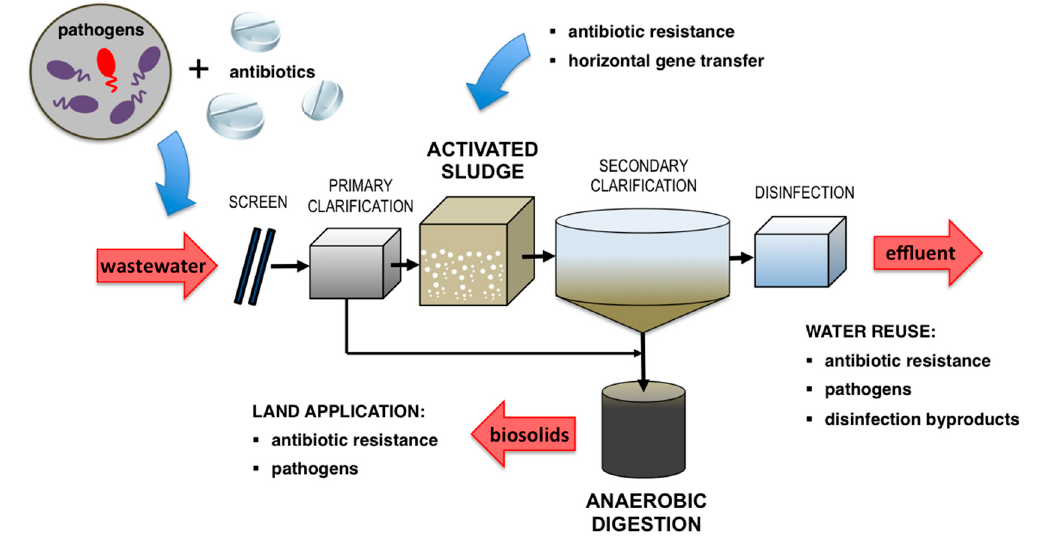
Figure 2. Schematic diagram of microbial antibiotic-associated threats in conventional wastewater treatment systems. treatment